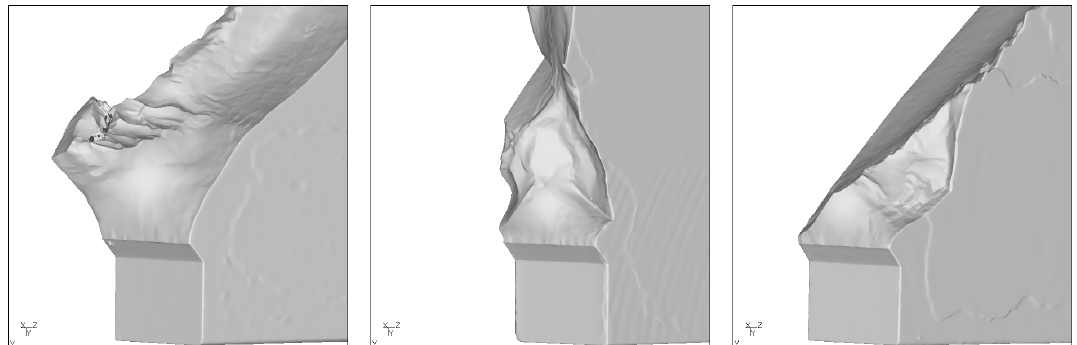
Figure 11. Three different experimental crack surfaces for loading conditions 0_1_90_1.